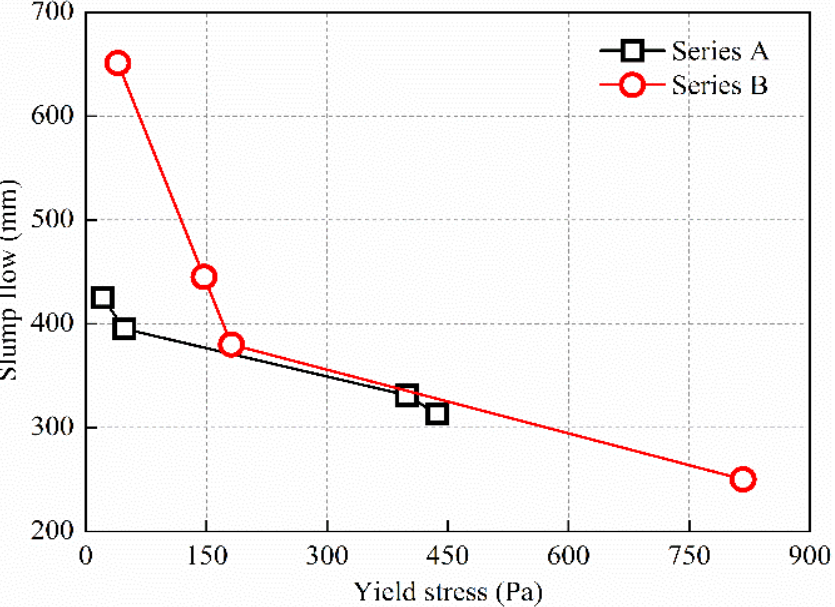
Figure 9. Relation between slump flow and yield stress of UHPC mixture.